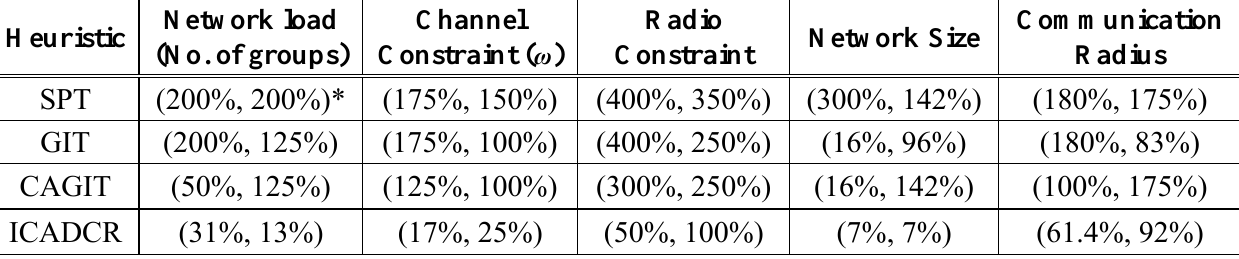
Table 1. Performance comparison between LGR and the other four heuristics.